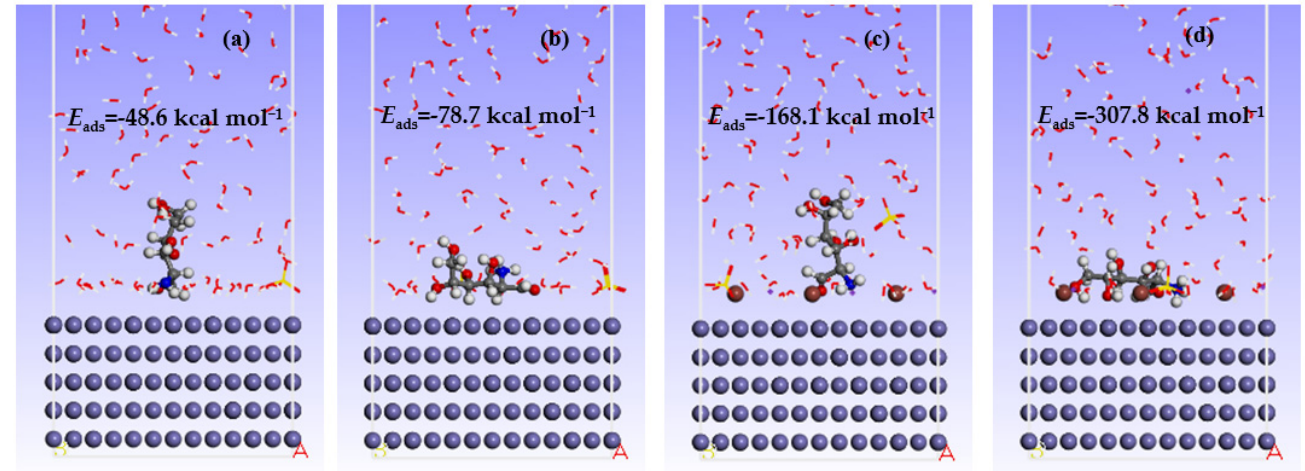
Figure 8. Equilibrium adsorption configurations of glucosamine molecules: ( a ) neutral glucosamine molecule on Fe(110) surface; ( b ) protonated glucosamine molecule on Fe(110) surface; ( c ) neutral glucosamine molecule on Fe(110) surface with idiom ions; ( d ) protonated glucosamine molecule on Fe(110) surface with idiom ions.